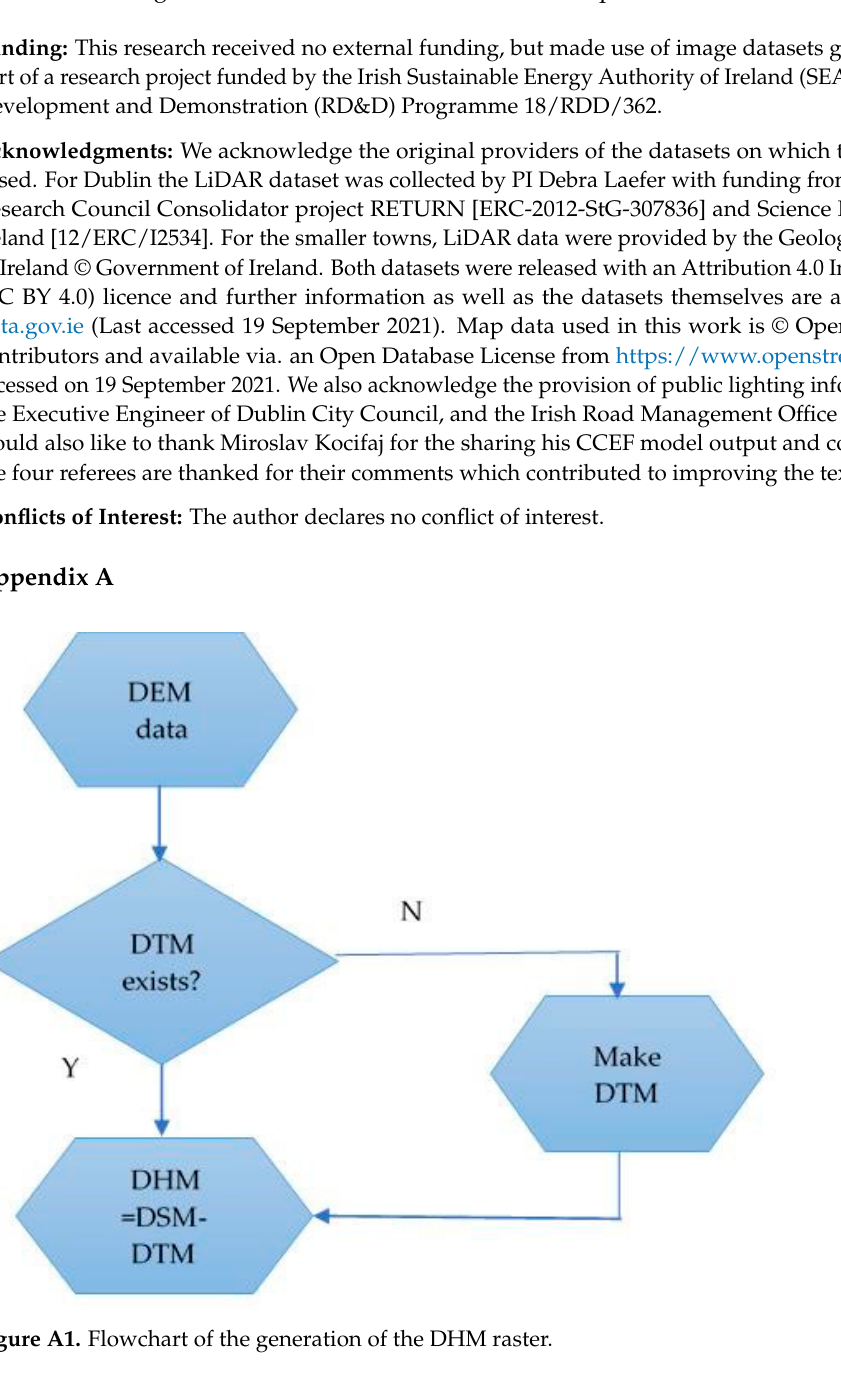
Figure A1. Flowchart of the generation of the DHM raster.